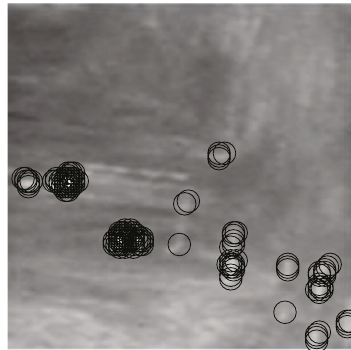
Figure 8: Metropolis-Hasting sampling of the likelihood distribu- tion depicted in Figure 2.